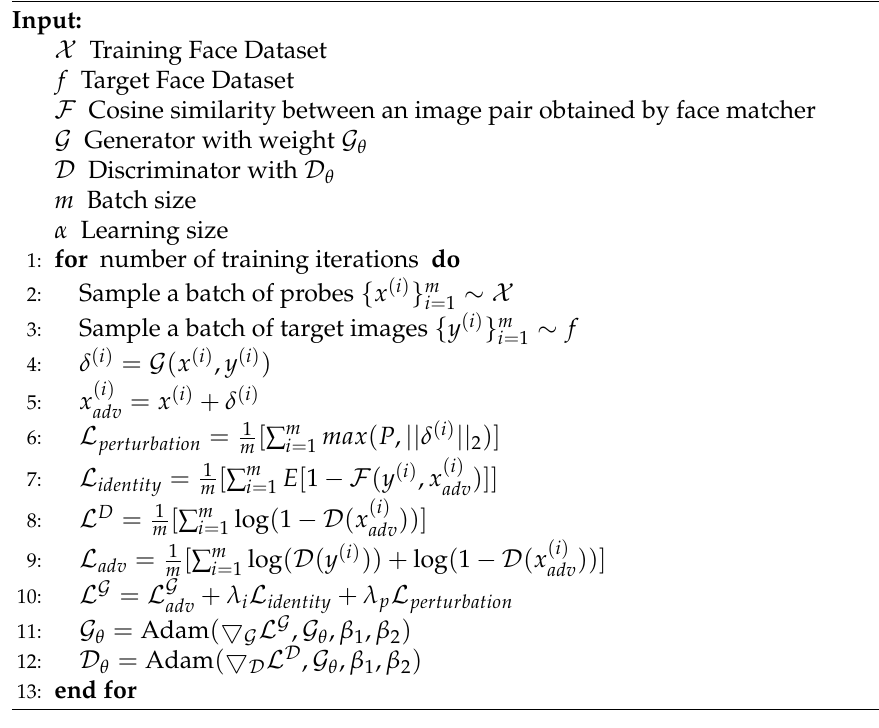
Algorithm 2 Training AdvFace in impersonation